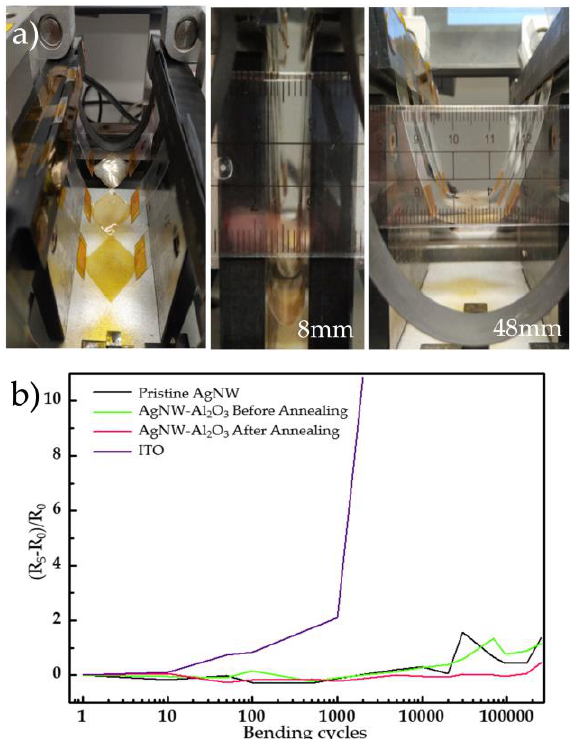
Figure 9. ( a ) Flexible bending test with a bending diameter of 8 mm, offset of 40 mm and ( b ) sheet resistance versus bending cycles in 250,000 bending cycles.